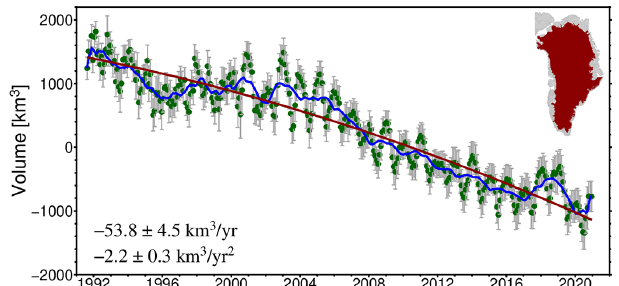
Figure 8. Volume change of the entire GrIS south of 81.5 ◦ N from our merged altimetric time series (green dots) and its correspond- ing result after removing seasonal oscillations using a 13-month moving average (blue solid curve). The solid red line is the best- fit quadratic curve for the linear- and quadratic-trend estimates of volume change. The grey error bars show the 1 σ uncertainty range of the altimetry data. The red-shaded area in the inset indicates the coverage of the GrIS with reference to the Greenland drainage sys- tem boundaries in Zwally et al. (2012).